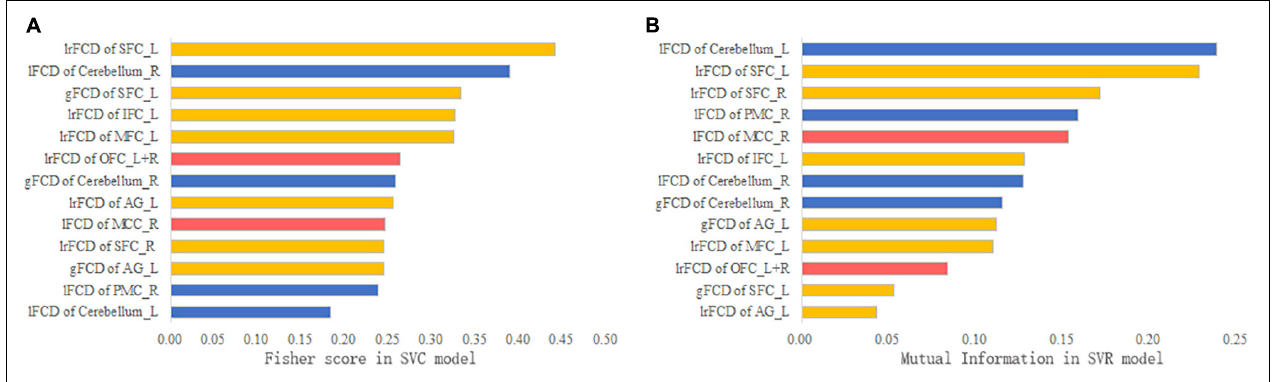
FIGURE 6 | The feature contribution. (A) The Fisher score of each feature in the SVC model. (B) The mutual information of each feature in the SVR model.